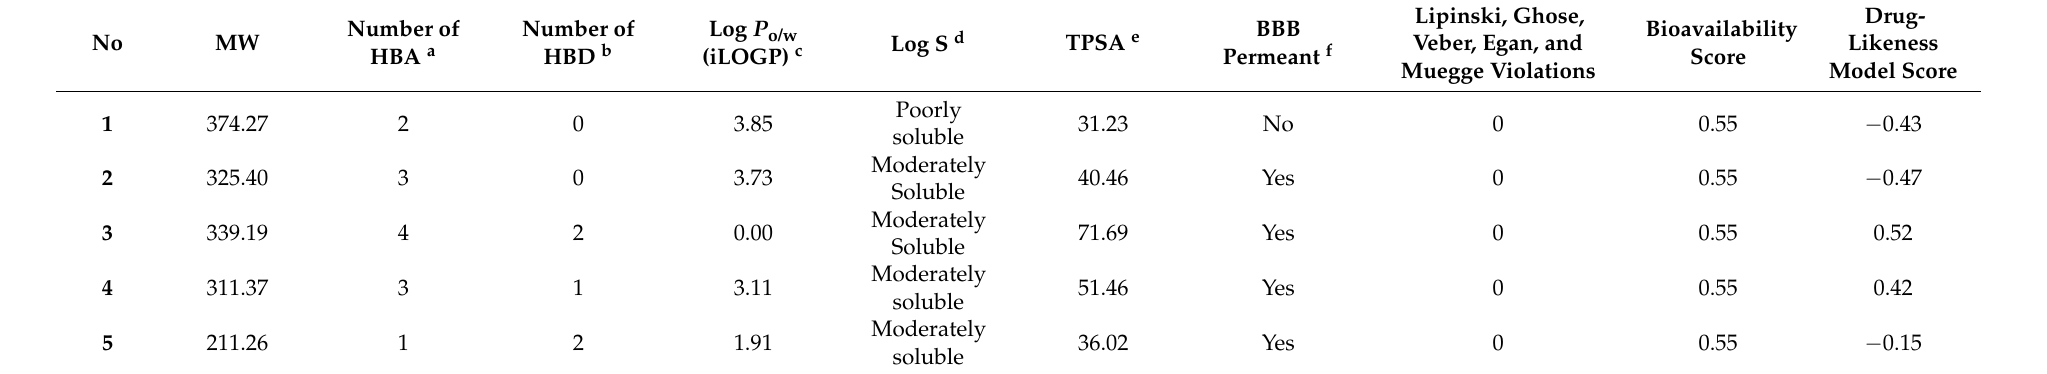
Table 3. Drug likeness predictions of tested